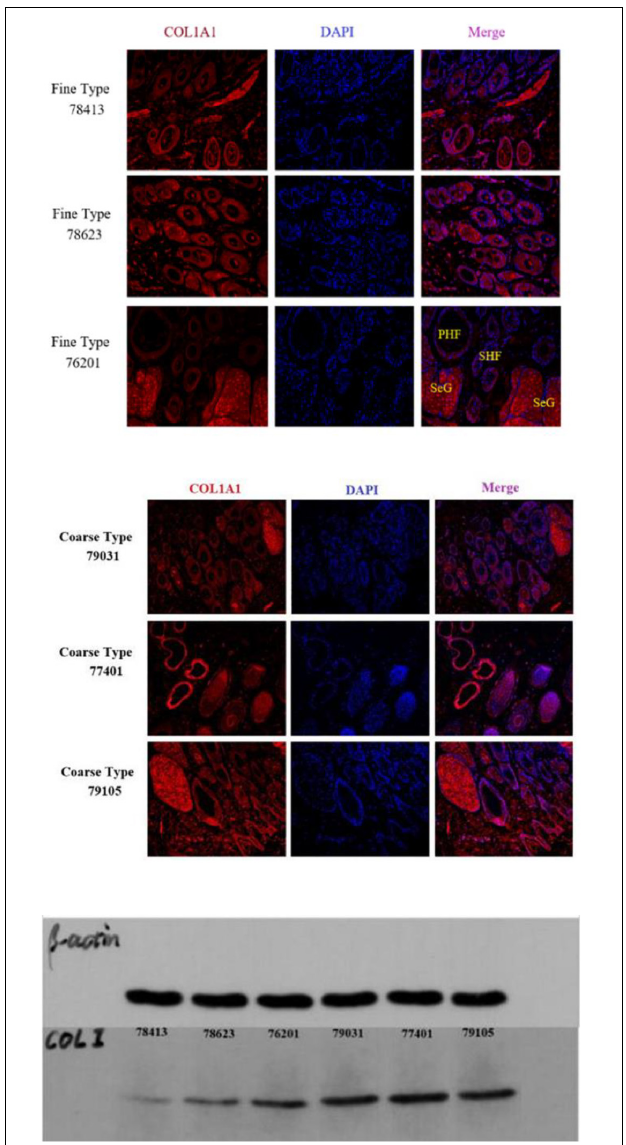
FIGURE 9 | IF results of COL1A1 in FT-LCG and CT-LCG skin tissues (200x).